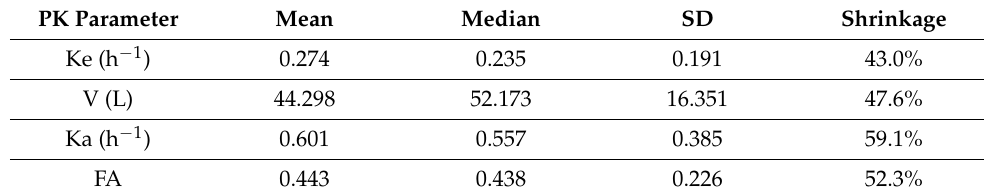
Table 2. PK parameters of final PK model ( N =